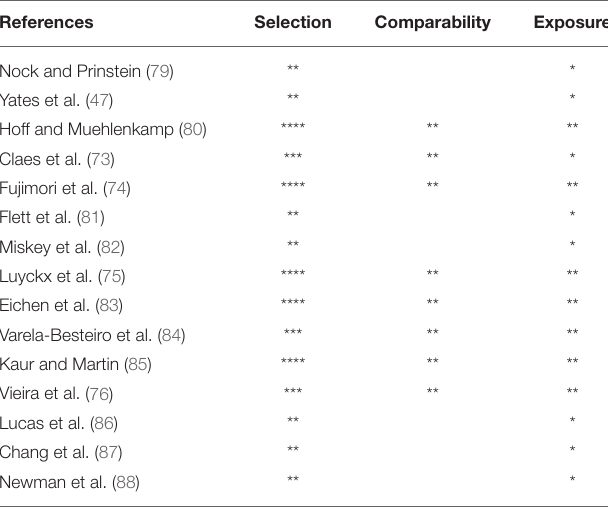
TABLE 3 | Quality assessment of the included